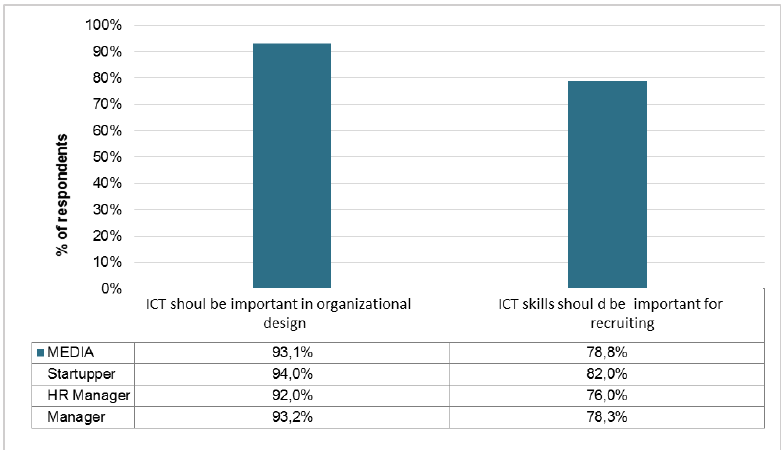
Figure 6. The Relevance of ICT Knowledge When